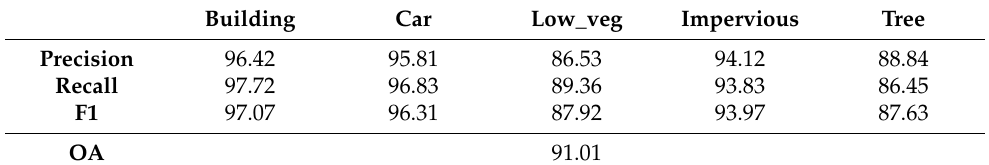
Table 5. OA (%) and per class F1 score (%) of the proposed “RS+Edge+DNL LAST “ network. Building Car Low_veg Impervious Tree Precision